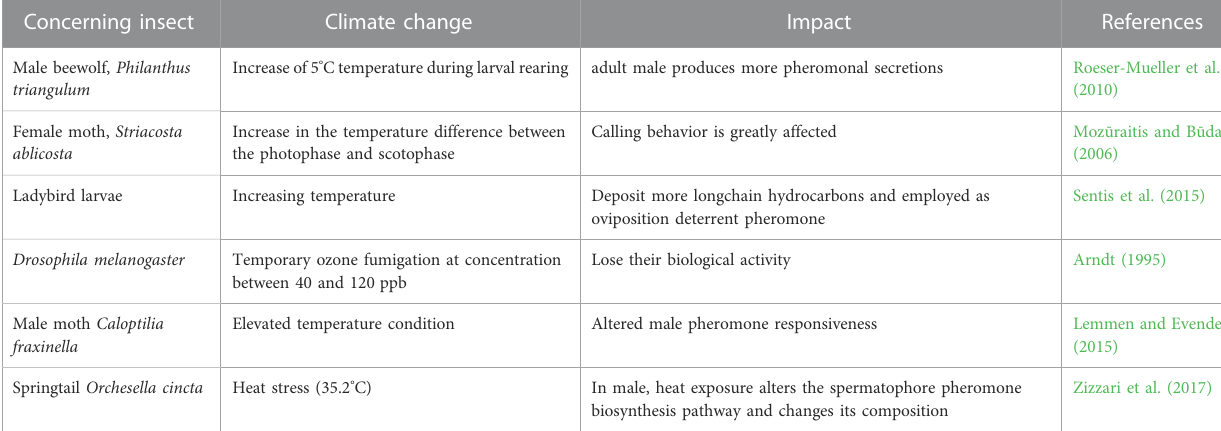
TABLE 2 Climate change interactions with pheromonal